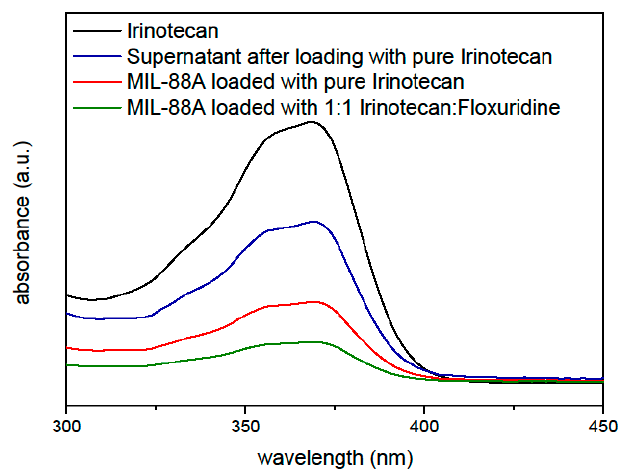
Figure 1. UV/Vis measurements to determine the loading capacity of Lip-MIL-88A nanoparticles for Irinotecan.